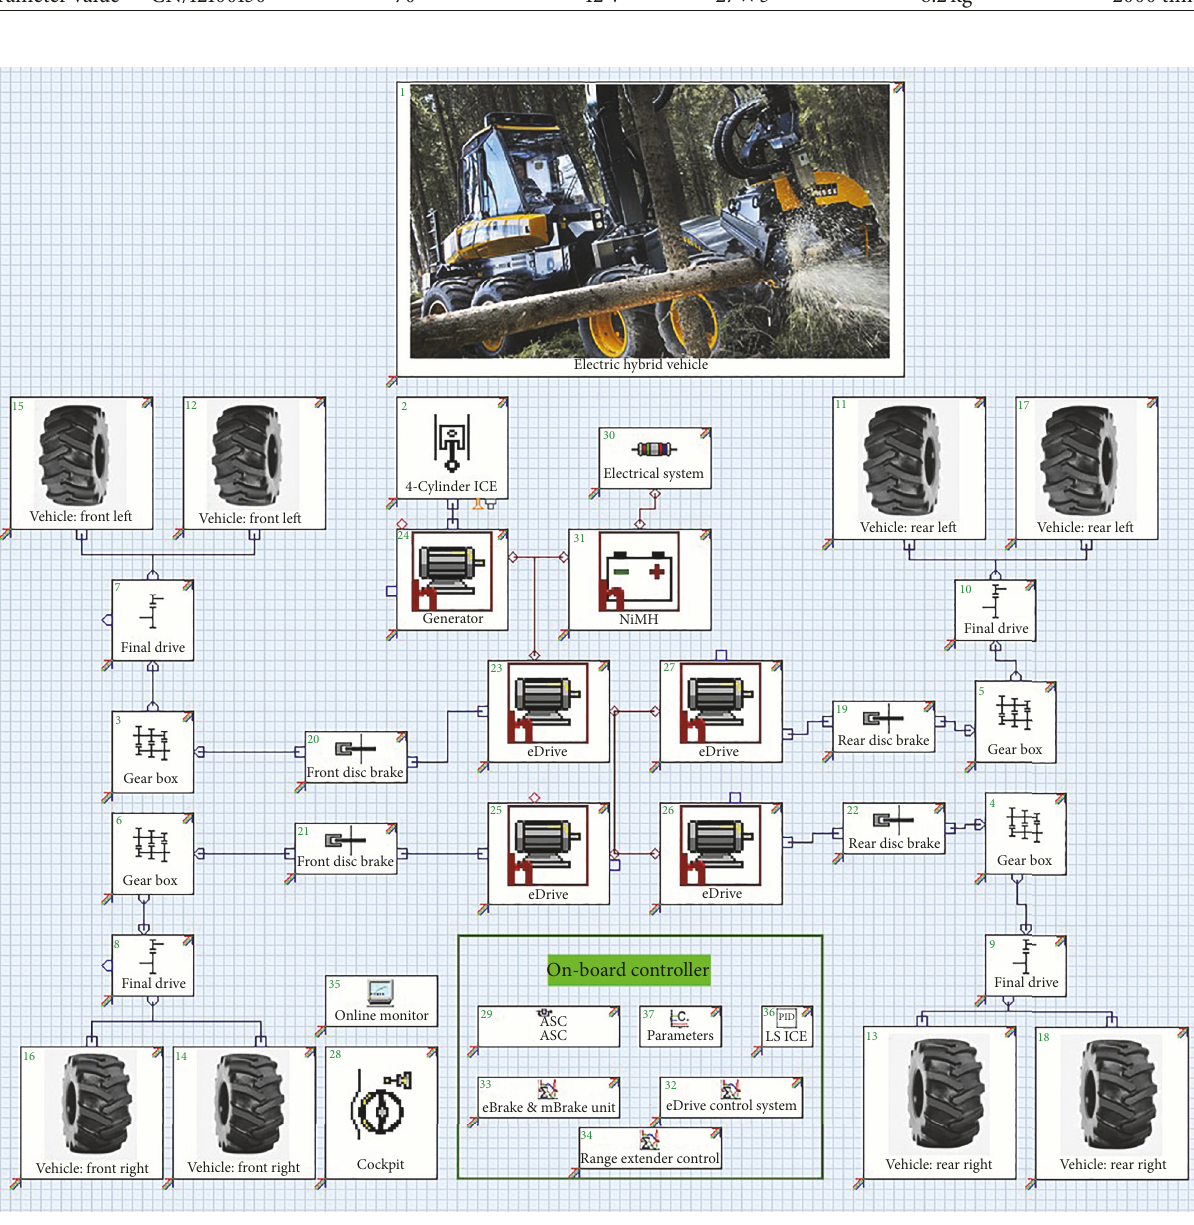
Figure 1: Model of CFJ20H hybrid power